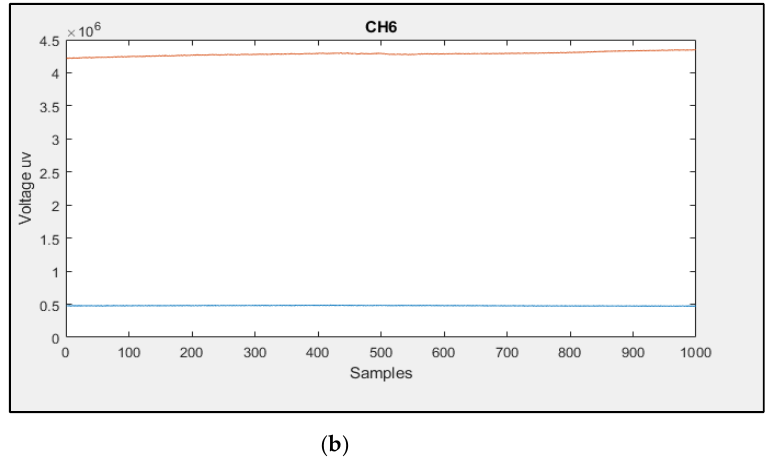
Figure 20. The recorded fNIRS data from ( a ) channel one and ( b ) channel six after subjecting the flexible PCB to 200 cycles of bending at different angles.